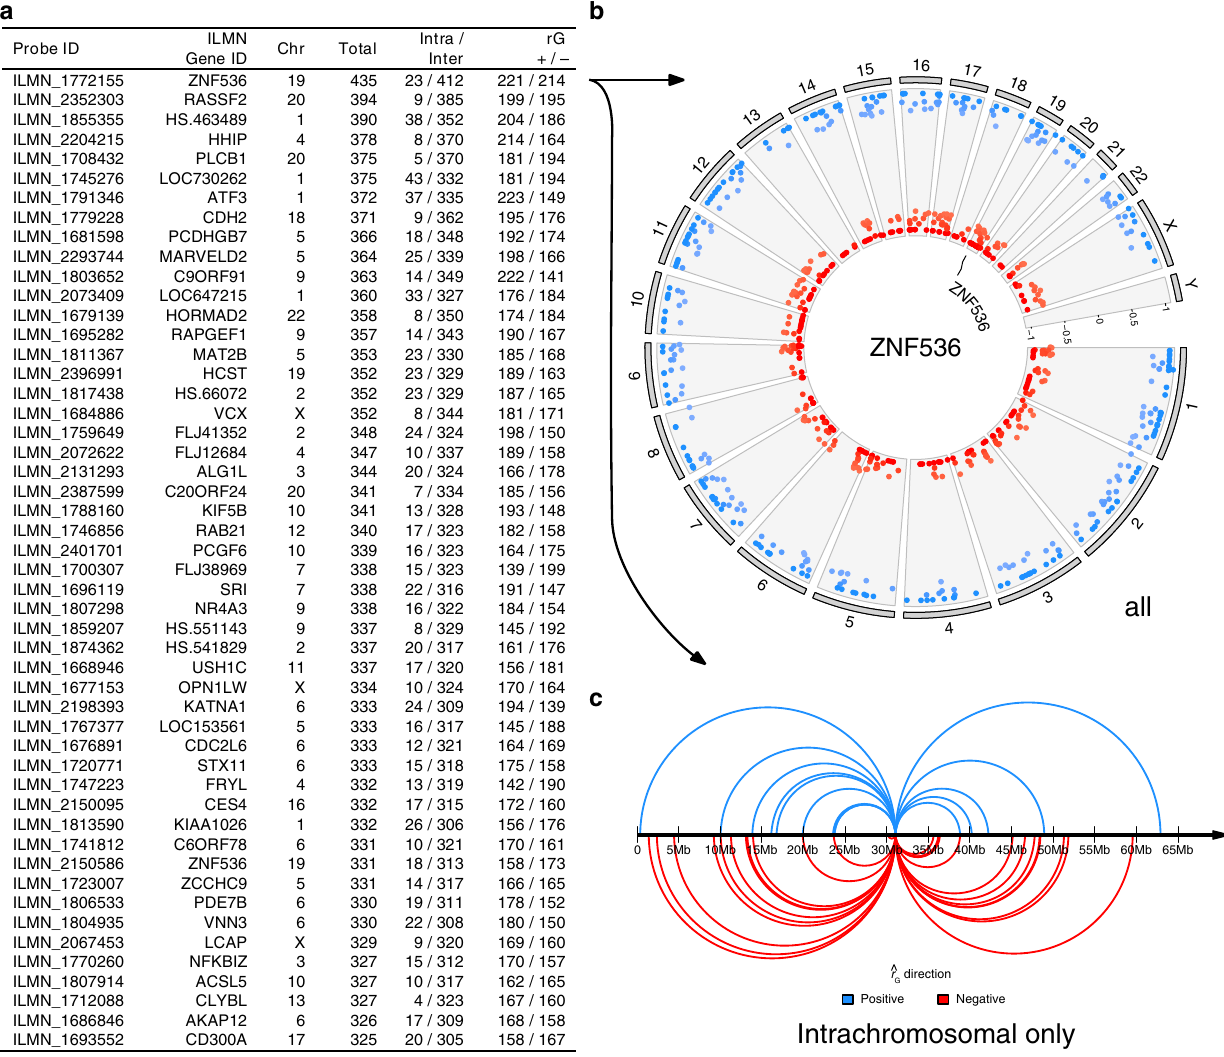
Fig. 5 Visualising highly connected, genetically correlated transcripts. a shows a table of transcripts with the highest number of connections above the threshold of 3 σ ( | ^ r G | ≥ 0.72), their chromosome number, total number of connections above the threshold, proportion of intrachromosomal/interchromosomal loci, and proportion of ^ r G with directionality. Using the example of ZNF536 , the gene with the highest number of connections at 3 σ , the transcriptome-wide connections at ≥ 3 σ are visualised as a circle plot . The circle plot shows the genomic position and associated ^ r G values for each transcript that is correlated with ZNF536 at ≥ 3 σ , represented as a heatmap ranging from − 1 to 1 ( red to blue ) ( b ). c shows intrachromosomal connections between transcript pairs at ≥ 3 σ . Positive and negative r G estimates are shown in blue and red , respectively. The complete table of transcript connections ≥ 3 σ is available in the supplementary materials. Circle ( b ) and arc ( c ) plots can be generated at the desired ^ r G threshold for genes in our data set via the browser